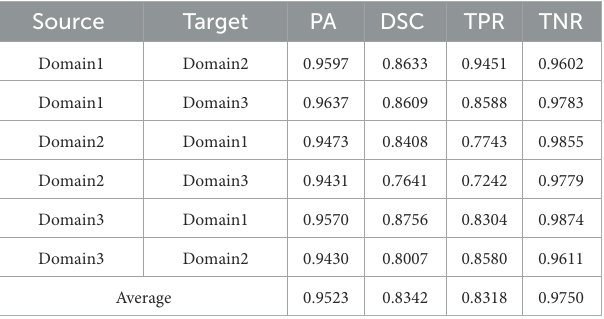
TABLE 5 Results on ultrasound thyroid nodule datasets with TRFEplus (38) + AUG.